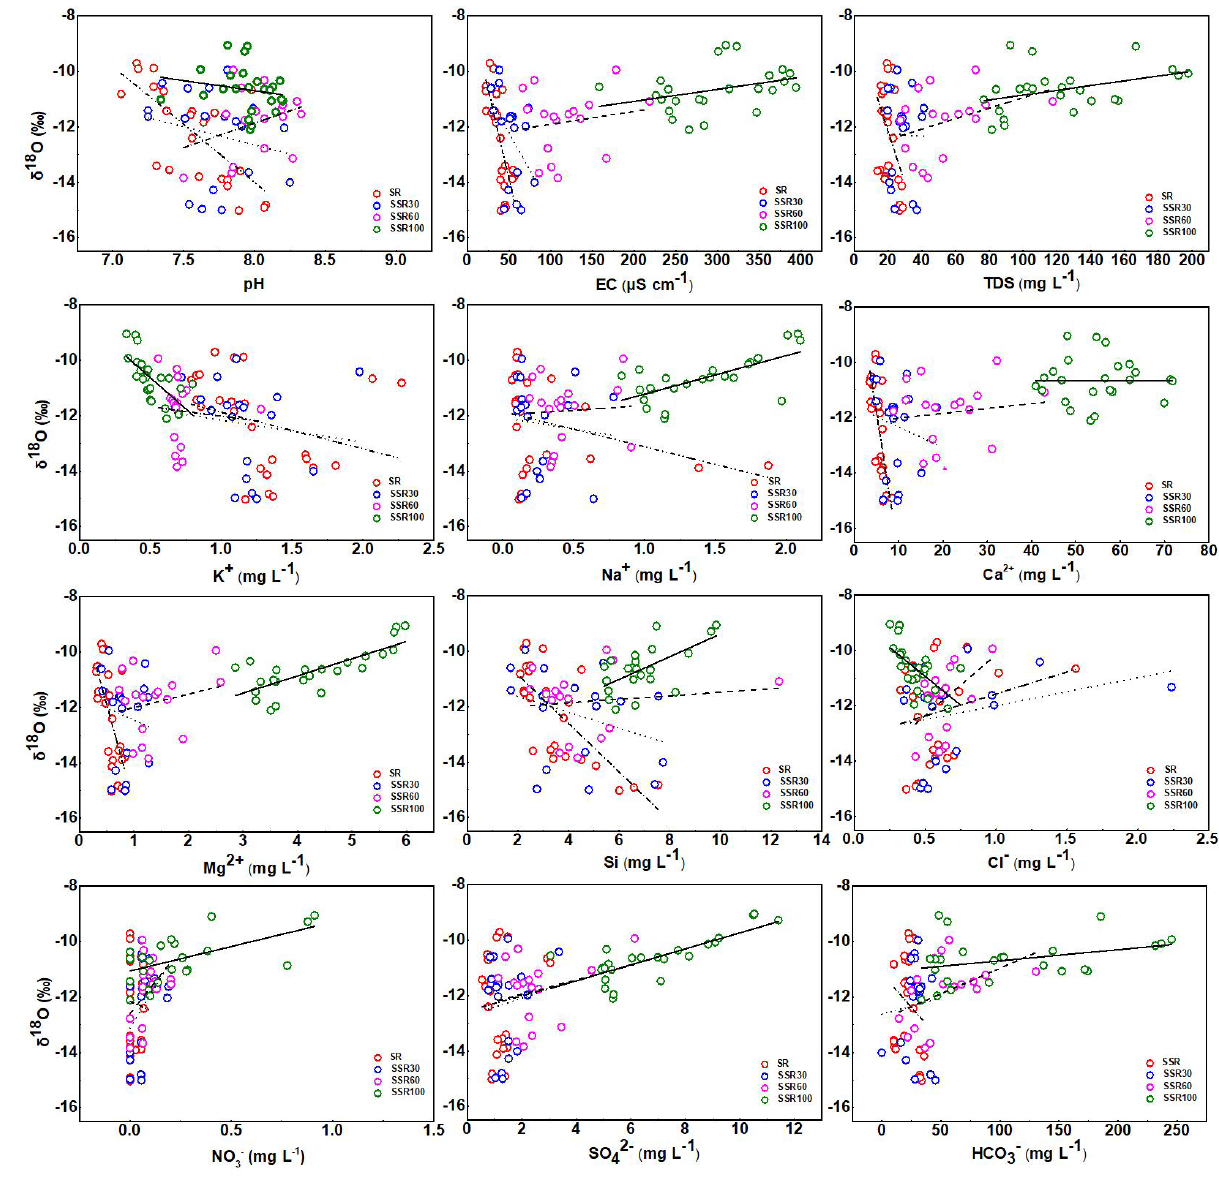
Figure 6. Relationship between δ 18 O and different hydrochemical